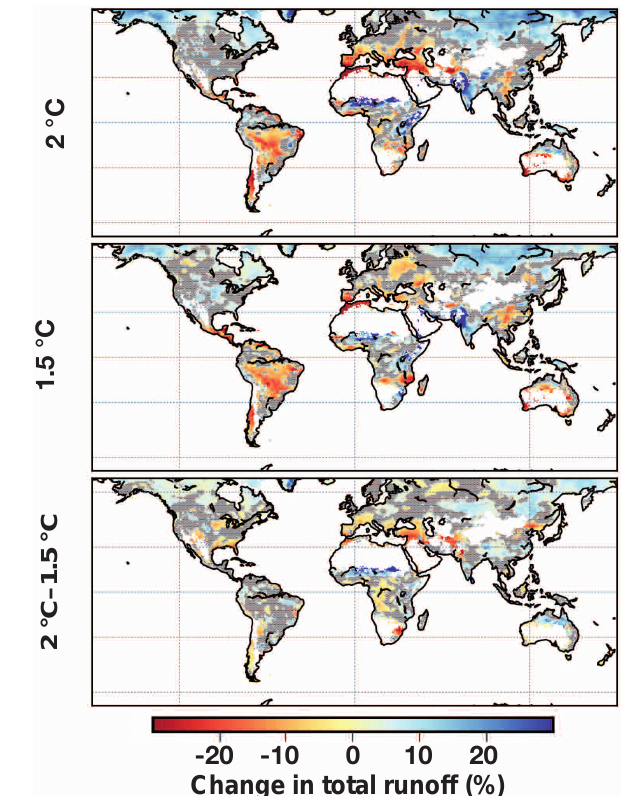
Figure 7. Median projections for changes in annual mean runoff for a warming of 2 ◦ C (upper panel), 1.5 ◦ C (middle panel) and the dif- ference between both levels (lower panel) relative to the 1986–2005 reference period. The projections are based on the ISI-MIP GCM- GHM model ensemble. Grid cells where less than 66% of all GCM- GHM pairs agree with the median sign of change are hatched out. Grid cells with an annual mean runoff of less than 0.05mmday − 1 are masked